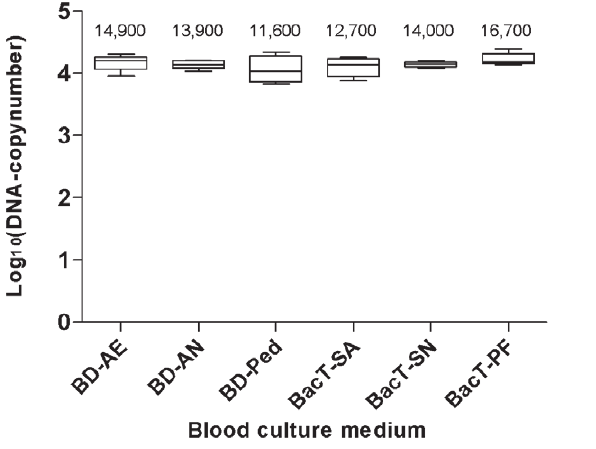
Figure 3. DNA recovery from different blood culture media. Estimated total copy-number of Leptospira interrogans DNA recovered from spiked samples of six different blood culture media containing approximately 50.000 Leptospira /5 m l. All DNA extractions were per- formed with M5, the improved protocol adapted for all blood culture media. The mean copy-numbers are given above each column. Error bars indicate the 95% confidence interval. BD-AE: BACTEC TM aerobic Plus, BD-AN: BACTEC TM anaerobic Plus, BD-Ped: BACTEC TM Paed Plus, BacT-SA: BacT/ALERT H SA, BacT-SN: BacT/ALERT H SN and BacT-PF: BacT/ ALERT H PF.